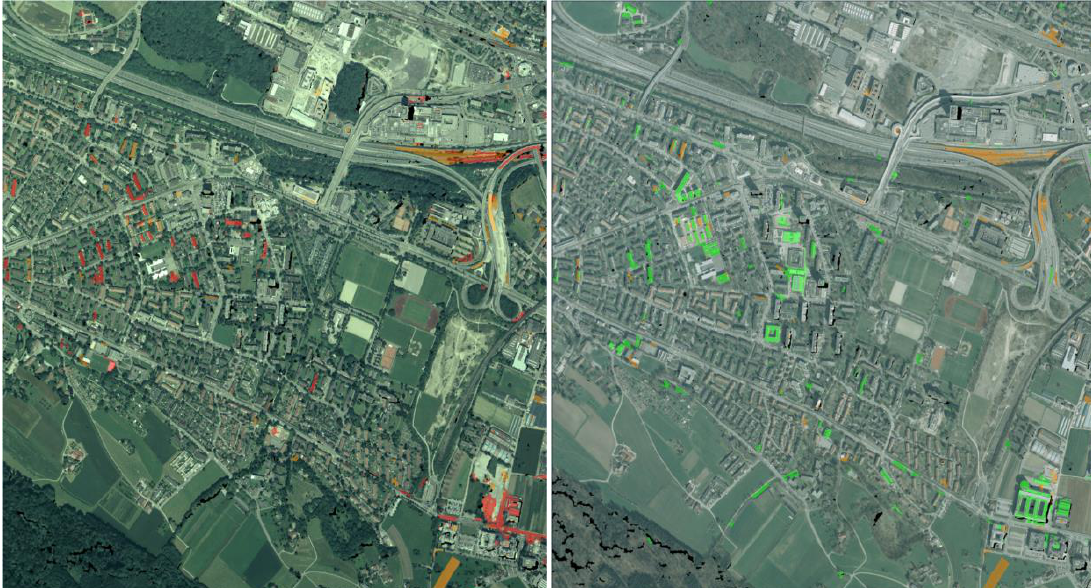
Figure 3. The experiment result. Left: orthophoto in the year 2002; middle: orthophoto in the year 2007; right: change detection results (red: demolished: green: new building; orange: uncertain changes).